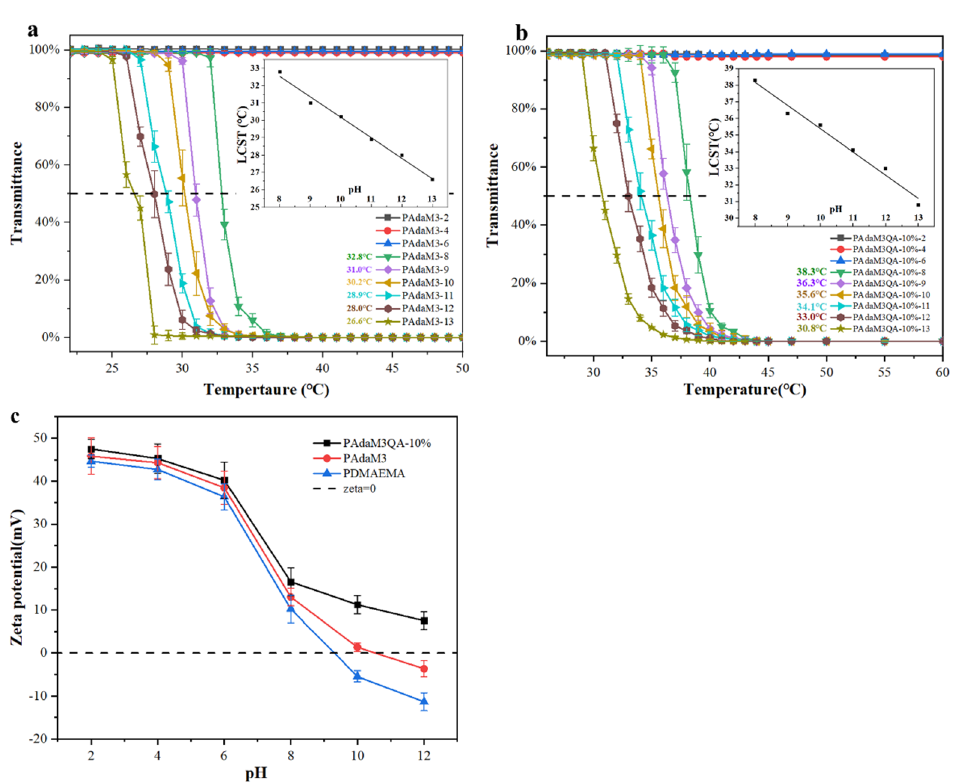
Figure 5. ( a ) The transmittance of PAdaM3 solution at different pHs; ( b ) the transmittance of PAdaM3QA − 10% solution at different pHs; ( c ) the zeta potential of PAdaM3QA − 10%, PAdaM3, and PAdaM0 solutions at different pHs.